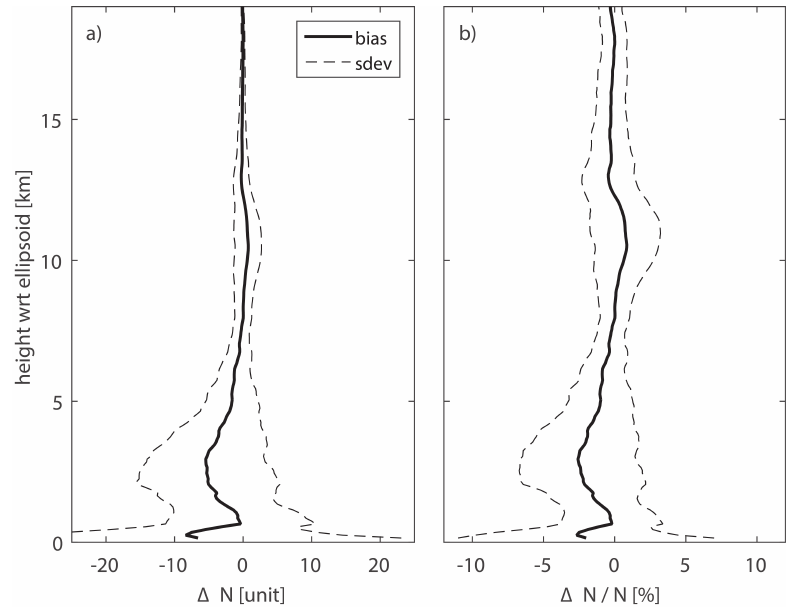
Figure 7. Mean bias (solid line) and standard deviation (dashed line) for refractivity differences between radiosonde and WRF model calculated in terms of ( a ) units of refractivity and ( b ) fractional errors in